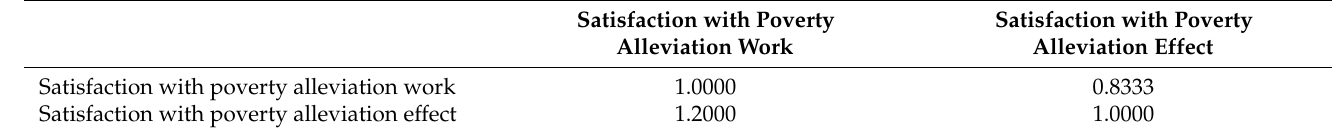
Table A4. B3–C: Judgement matrix of the satisfaction with poverty alleviation.